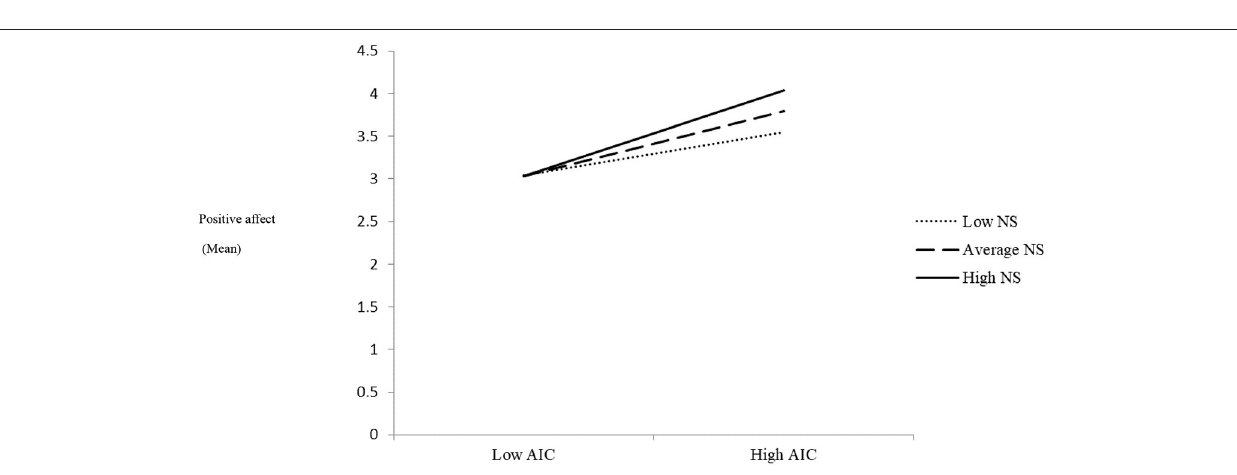
FIGURE 3 | Interaction effect between AIC and need satisfaction (NS) on students’ positive affect. This figure displays the interaction plot for the association between AIC and positive affect under low, moderate, and high levels of need satisfaction. As can be seen, the association between AIC and positive affect became stronger as the level of need satisfaction